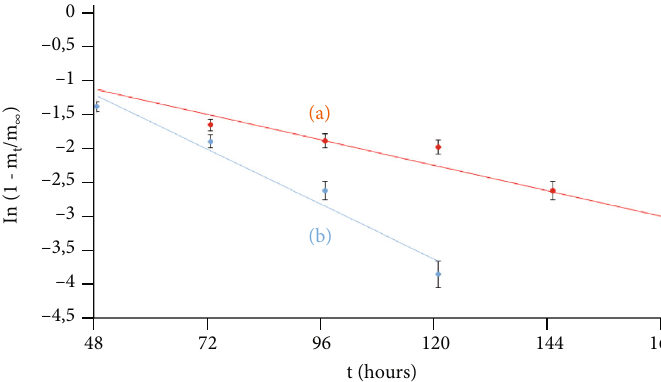
Figure 7: Final region of the kinetic curve illustrating OZ release from MPs: (a) OZ-MP